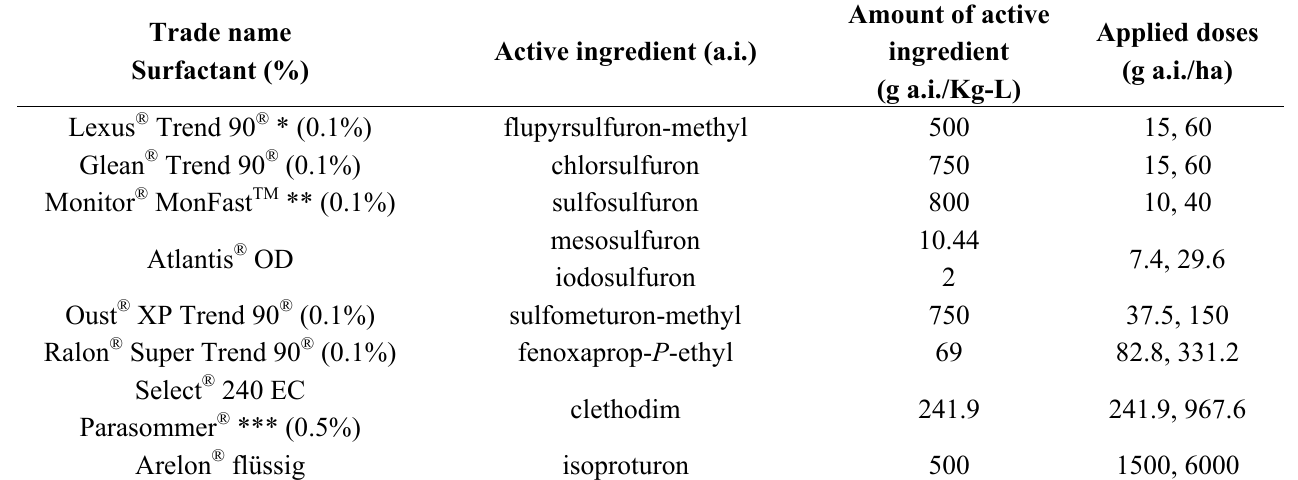
Table 4. Herbicides used for the greenhouse resistance screening